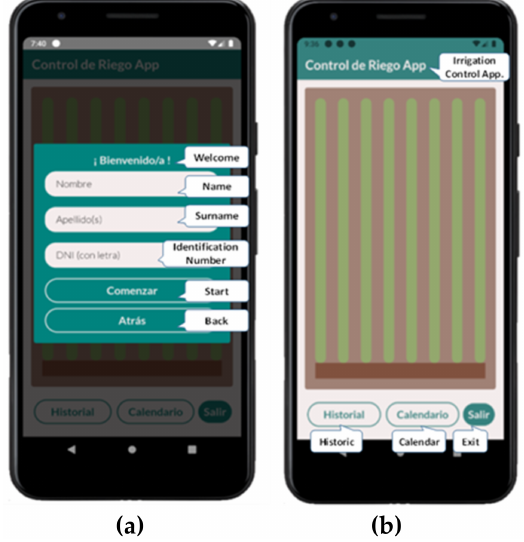
Figure 12. ( a ) Registration form; ( b ) main screen of application.